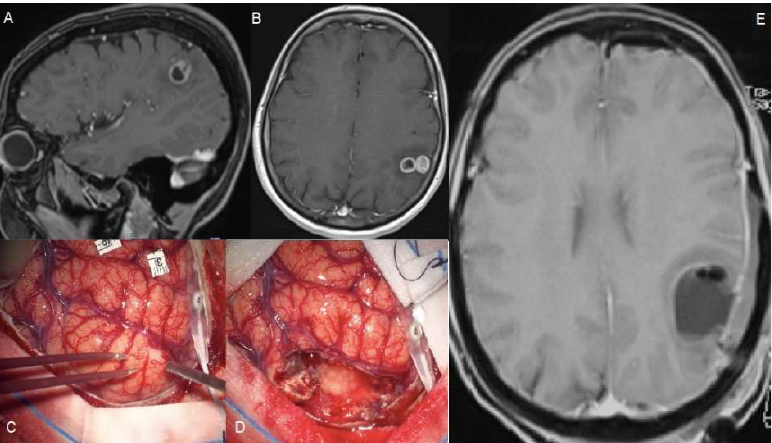
Figure 2. A 56-year-old female suffered a single seizure (speech articulation impairment lasting 10 min). The upper figures ( A , B ) show pre-operative T1 gadolinium-enhanced MRIs of a Glioblastoma infiltrating the left supramarginal gyrus. The patient was operated on through an awake craniotomy and direct language mapping ( C , D ). Since the mapping did not show activation areas on the supramarginal gyrus, a complete gyrus resection was performed. ( E ) The post-operative MRI confirmed the complete resection not only of the tumor but also of the gyrus. Post-operatively, the patient did not experience any speech disturbances.